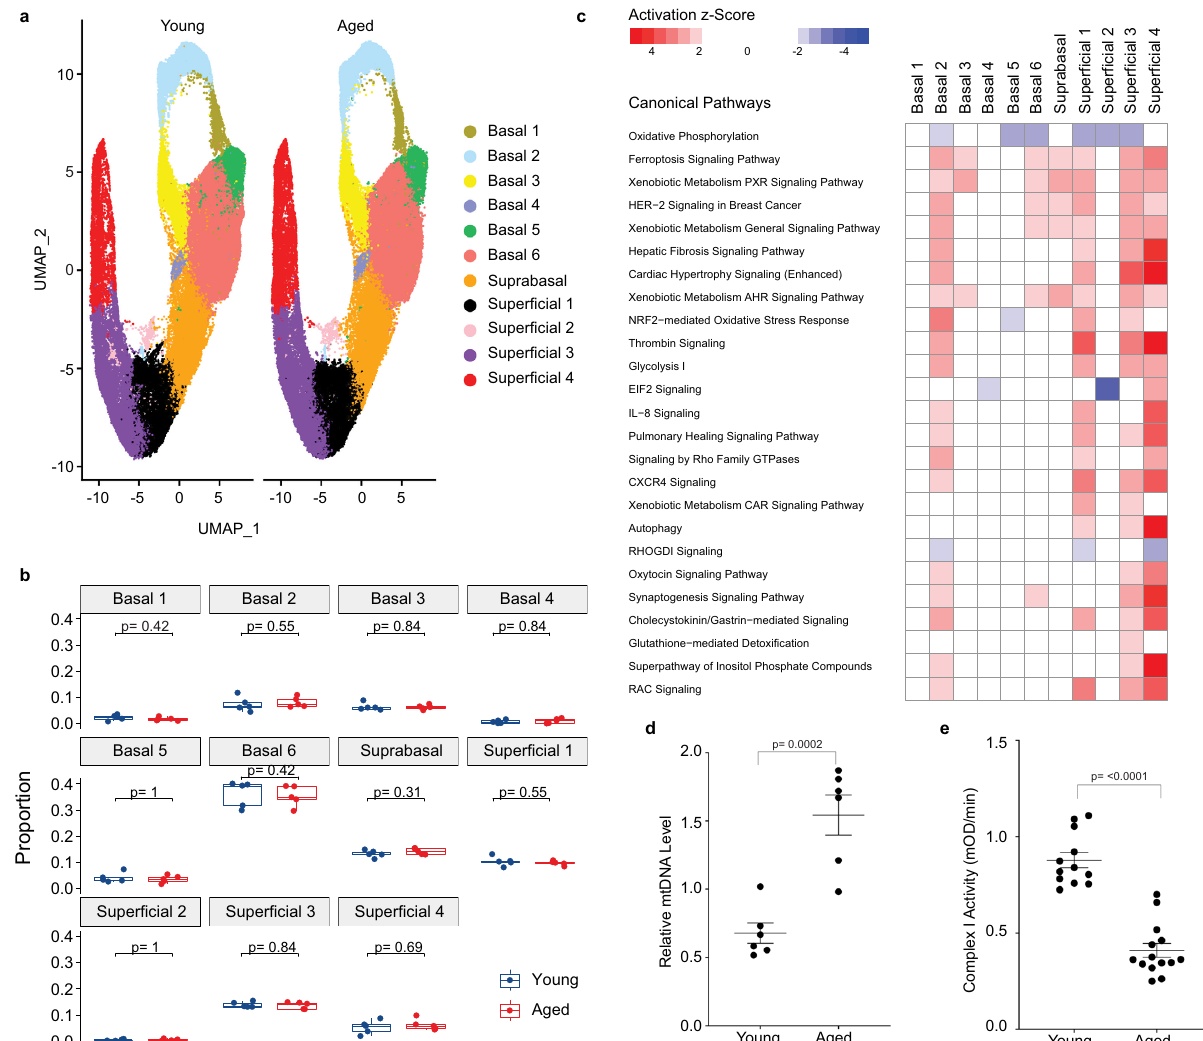
Fig. 4 Age-associated alterations in murine esophageal epithelium. a Uniform Manifold Approximation and Projection (UMAP) visualization of Seurat cell populations in young and aged esophageal epithelium. b Proportion of each cell population as a fraction of all cells in the epithelium for each age group ( n = 5 animals per age group). Indicated p values were determined using Wilcoxon signed-ranked test without adjustment for multiple comparisons. Log 2 of the odds ratio of fractional proportions of each cell population. Odds ratio calculated by fractions in each respective cluster in aged mice over young mice. Each individual scatter point represents proportion indicated, box indicates quartiles, whiskers indicate minima and maxima. Mean is indicated by line striking through box. c Ingenuity pathway analysis identi fi ed the canonical pathways signi fi cantly altered in esophageal epithelial cell populations in aged mice relative to young mice. A positive value (red) indicates activation while a negative value (blue) indicates inhibition of the respective pathway. d DNA level of mitochondrial D-loop was determined relative to nuclear DNA-encoded gene Ikb β in epithelial-enriched mucosal layer from young ( n = 6 animals) and aged ( n = 6 animals) C57B6 mice. * p = 0.0002. e Mitochondrial complex I activity was measured in esophageal tissue lysates from young ( n = 12 animals) and aged ( n = 14 animals) mice. * p < 0.0001. In ( d , e ) two-tail e d t test was used to compare means and data are represented as mean ± SEM. Source data are provided as a Source Data fi